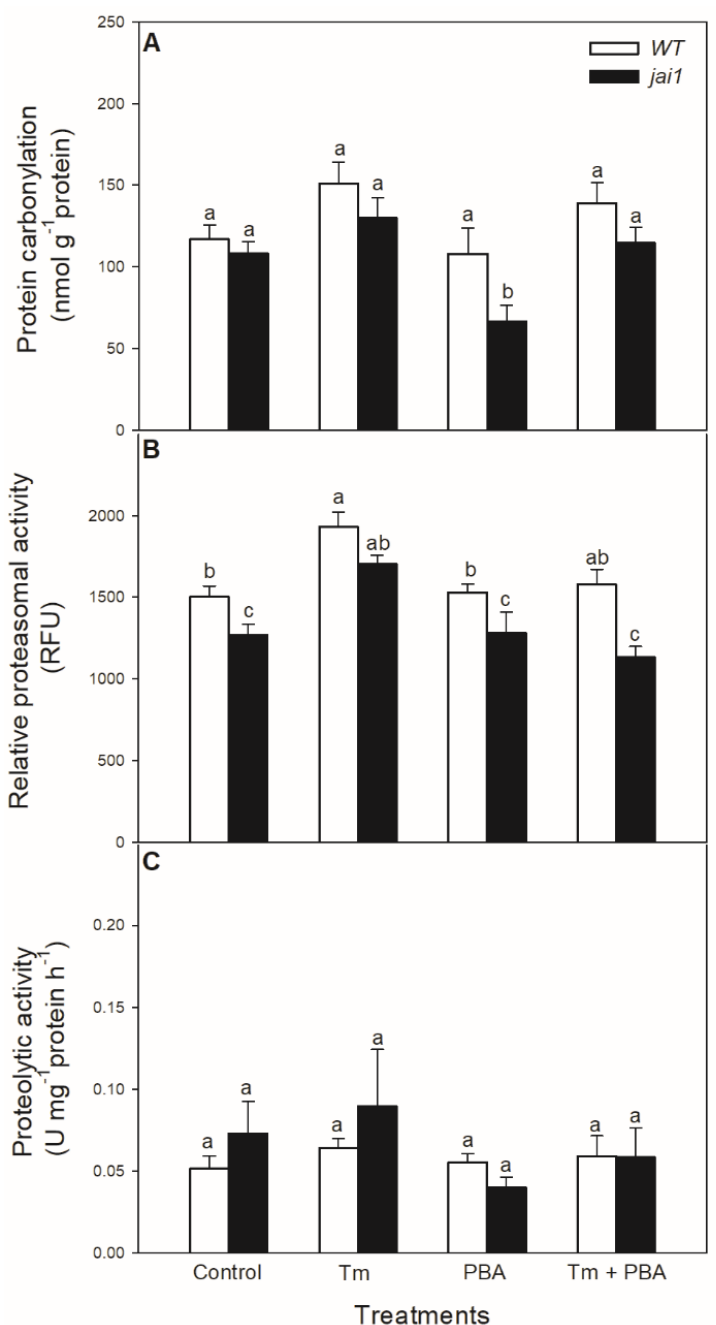
Figure 8. Changes in protein carbonylation ( A ), proteasomal activity ( B ), and total proteolytic activity ( C ) in the leaves of wild-type (WT) and JA signalling mutant (jai1) tomato plants exposed to 5 µ g mL − 1 tunicamycin (Tm), 1 mM 4-phenylbutyrate (PBA), and Tm + PBA for 6 h. Results are the means ± SE. Data with different letters indicate significant differences at p < 0.05 level, n = 3.